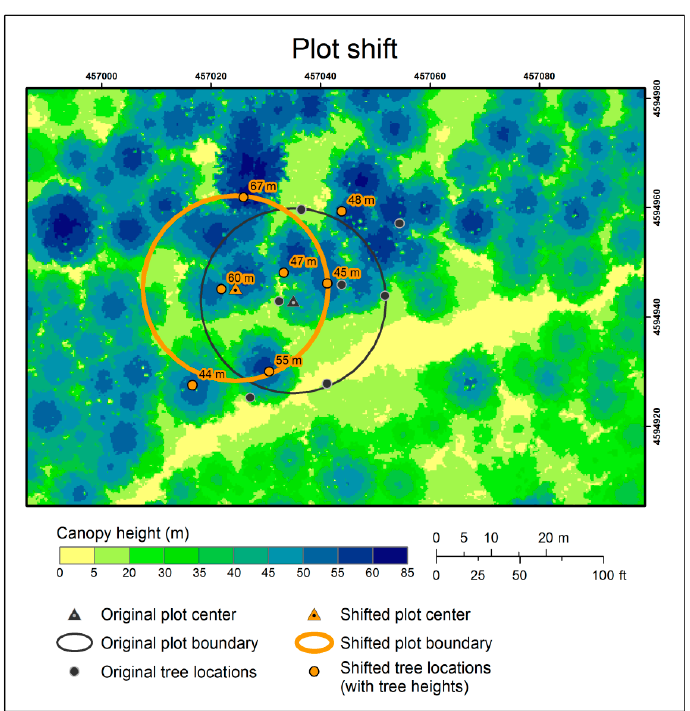
Figure 3. The original plot location and new, shifted plot location are shown with the locations of mapped tall trees in relation to plot center. Tree heights are shown with the shifted tree